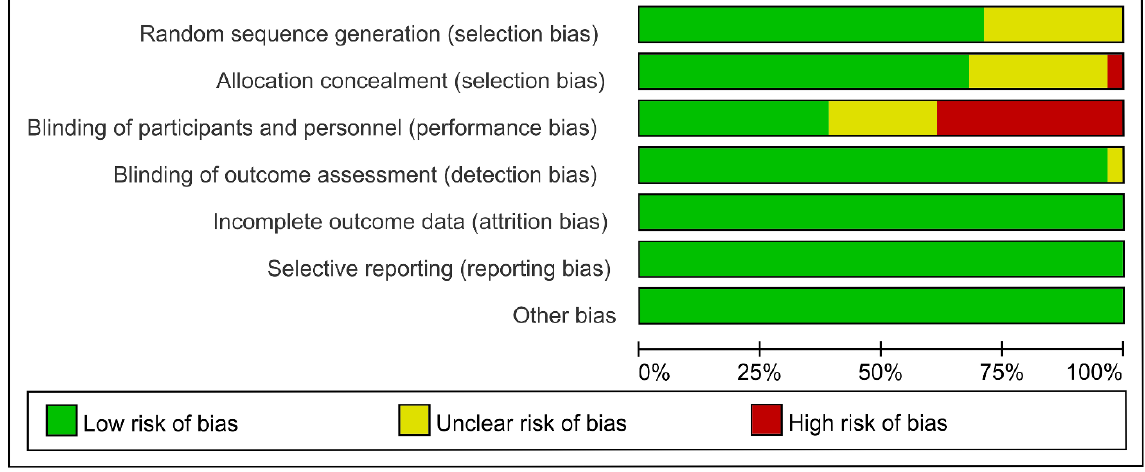
Figure 3. Risk of bias graph: review author’s judgements presented as percentages.